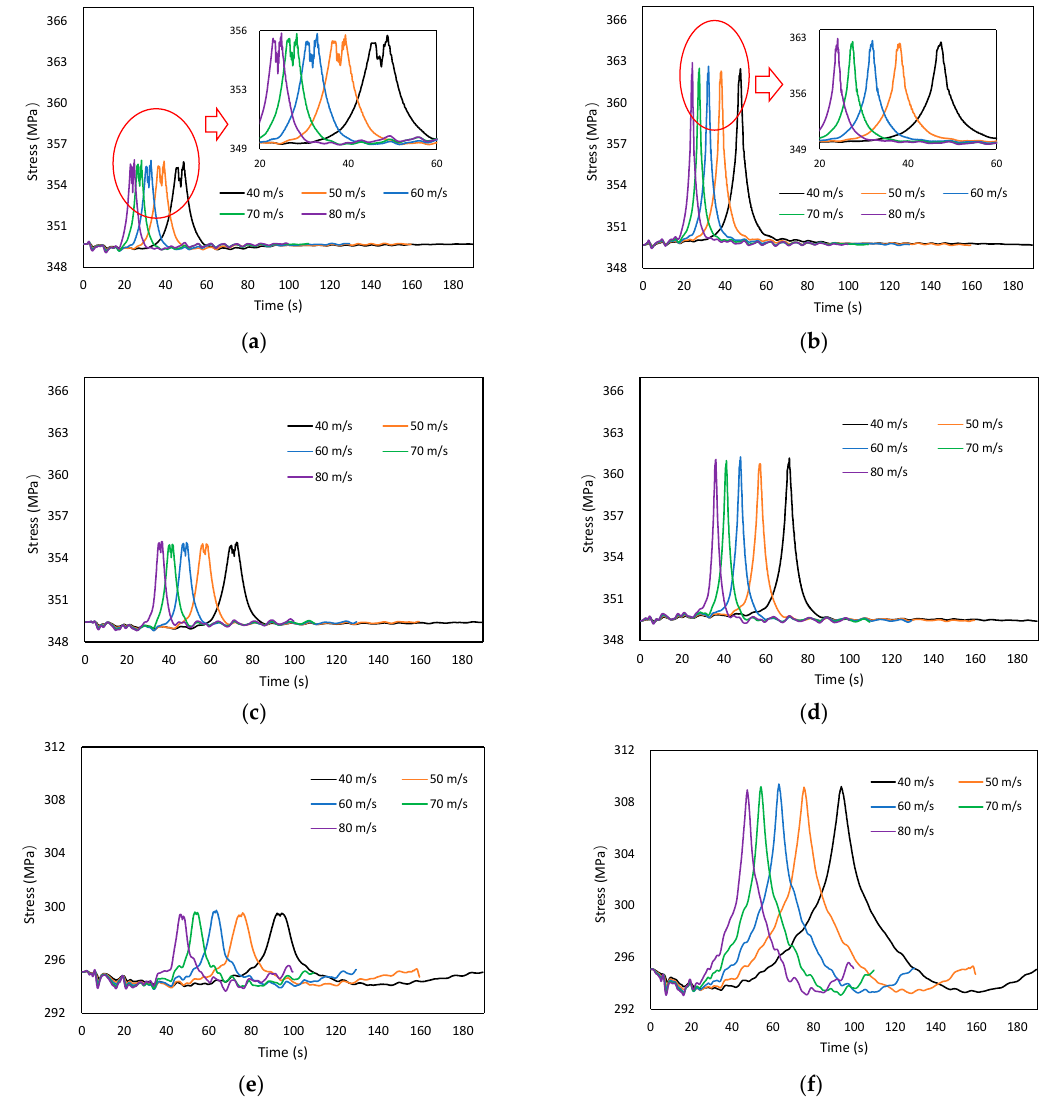
Figure 15. Time-dependent laws of suspender stress with di ff erent vehicle speeds. ( a ) Suspender A, ( b ) Suspender B, ( c ) Suspender C, ( d ) Suspender D, ( e ) Suspender E, ( f ) Suspender F.